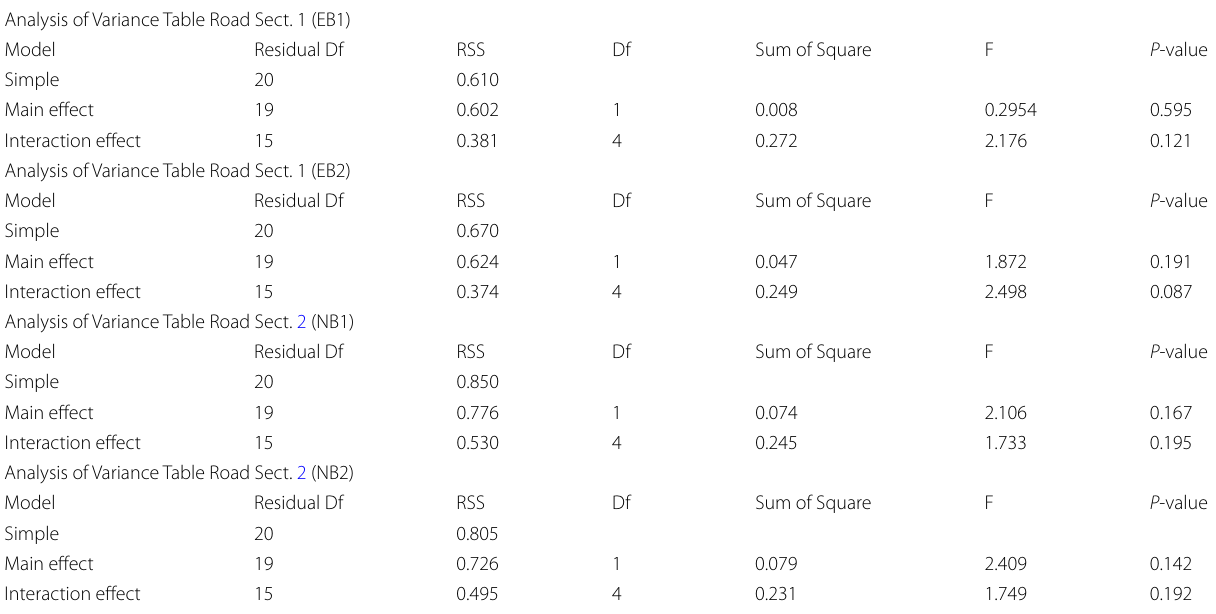
Df represents degrees of freedom and RSS represents residual sum of squares